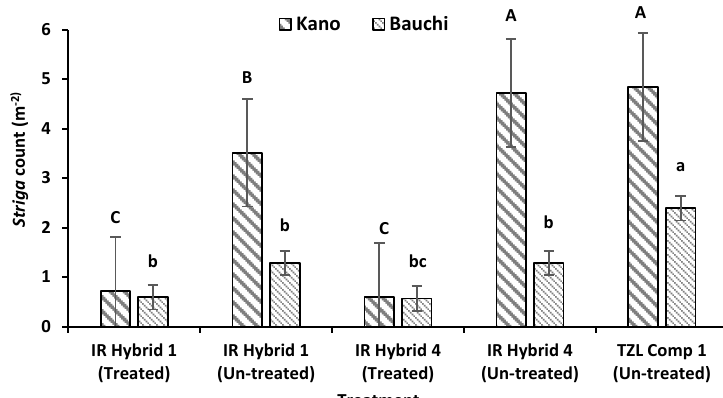
Figure 2. E ff ect of seed coating of IR maize hybrid with imazaphyr on Striga count in farmers’ fields in Kano and Bauchi 2014. IR maize: imazapyr-resistant maize hybrids.